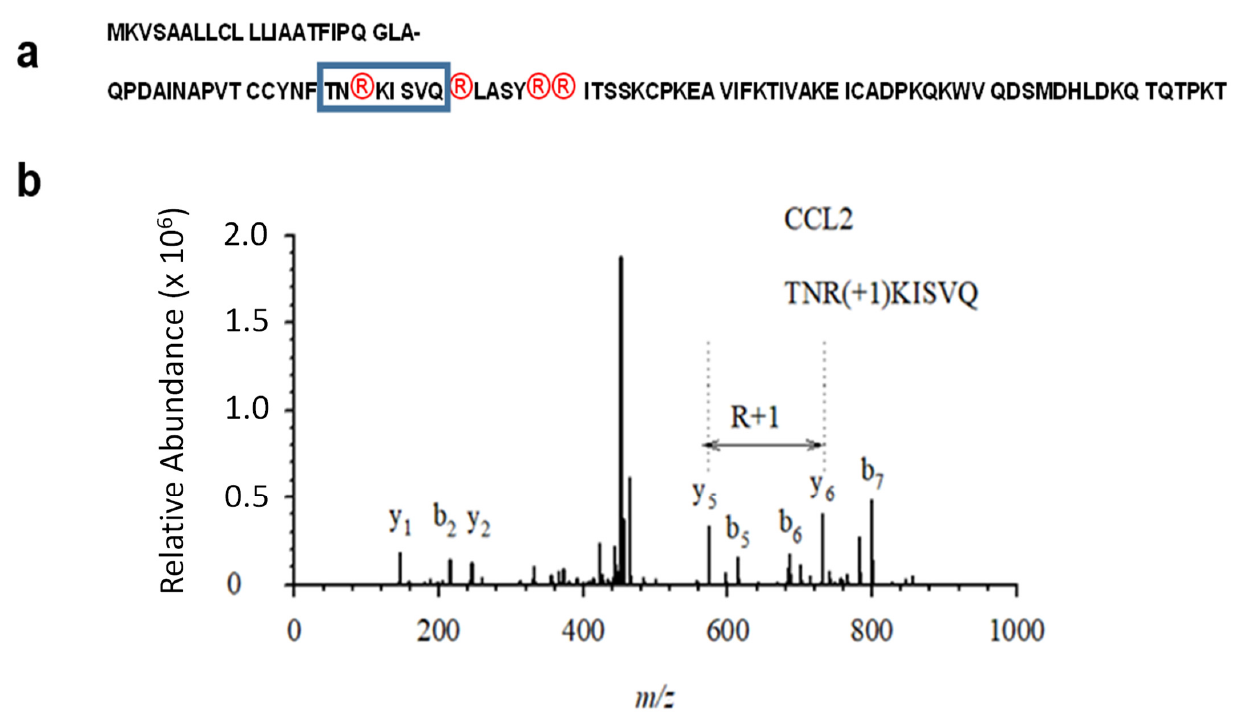
Figure 2. Mass-spectrometry verification of successful in vitro citrullination of MCP-1/CCL2. ( a ) Amino acid sequence of MCP-1/CCL2 (mature form of the protein spans residues 24–99). The first row shows 23 amino acid-long signaling peptide and the second row–mature protein of 76 residues. All arginine residues are highlighted with circles. The boxed areas show the peptide that contains the citrullinated arginine residues that were detected. ( b ) Annotated tandem mass spectrometry (MS/MS) fragmentation spectrum for the citrullinated MCP1/CCL2 peptide, showing the citrulli- nated arginine residue at position 3 of the studied peptide (R45). The MS/MS fragmentation data were annotated using Expert System (Max Planck Institute of Biochemistry). The precursor ion was observed with a mass error of 1 part per million, and the error for the fragment ions was 0.02 daltons. The quality and quantity of in vitro citrullinated E. coli expressed recombinant pro- tein purchased from R&D systems (Figure 3a) was compared with the self-made recom- binant protein produced in HEK293T cells (Figure 3b) using an ELISA specific for this protein. Interestingly, upon successful citrullination (Figures 1 and 2) all of the prepara- tions (two commercially produced ones and multiple aliquots of self-made prep) of bac- terially produced chemokines appeared to be very unstable: we were able to detect some random remains of recombinant proteins in such preps, exclusively immediately after the in vitro citrullination reaction. All of the citrullinated bacterial proteins were undetectable upon storage under − 70 °C. A suitability of the mammalian cells-produced chemokine standards was confirmed with a high coefficient of determination (R 2 = 0.99386, Figure 3b) versus the low R squared value for the bacterially produced chemokine (R 2 = 0.70629, Fig- ure 3a). Thus, we have shown that in vitro citrullinated mammalian cell-produced (Figure 3b), but not the bacterially produced MCP-1/CCL2 chemokine (Figure 3a) can be effi- ciently used as the good quality standards in ELISA.